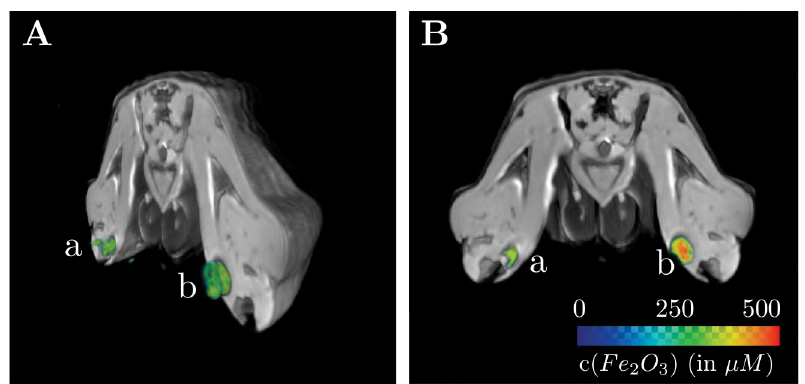
Fig 7. Results of the SVM-based localization method for the in-vivo study. A: Cross-section of a 3D reconstruction of the rat ’ s pelvis together with a rendering of the total volume of identified cancer cell aggregates. 500.000 CC531 cells labeled with 30 μ g SPIO were injected in the left rear limb (a), 500.000 R1H cells labeled with 50 μ g SPIO in the right rear limb (b). The injection volume was 50 μ l for both, a and b. B: Cross-section of a rat pelvis. The MR magnitude signal is displayed in grayscale, the Fe 2 O 3 concentration of labeled cells is color-coded. The colorbar applies to A and B.